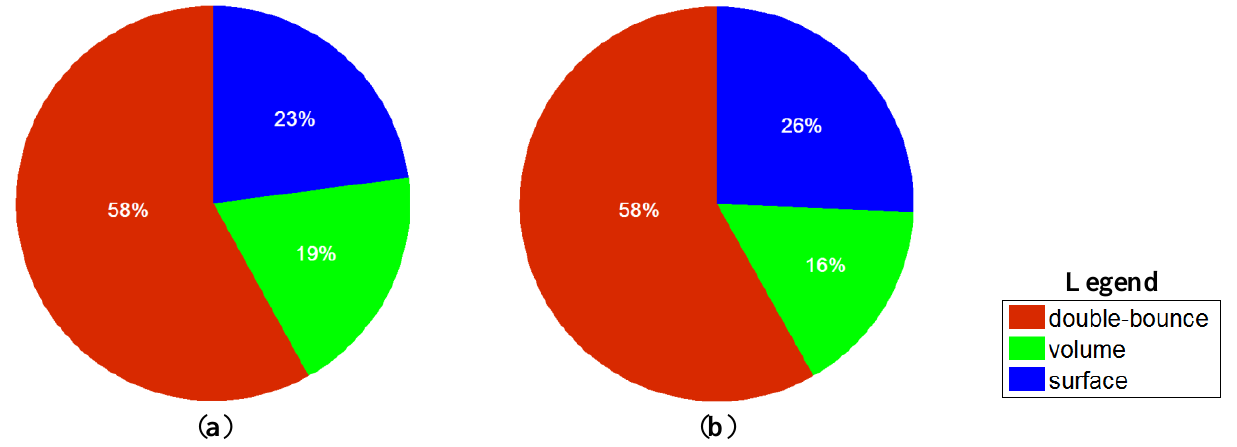
Figure 6. ( a ) Power distribution of original Freeman-Durden decomposition in urban area; ( b ) Power distribution of proposed adaptive decomposition in urban